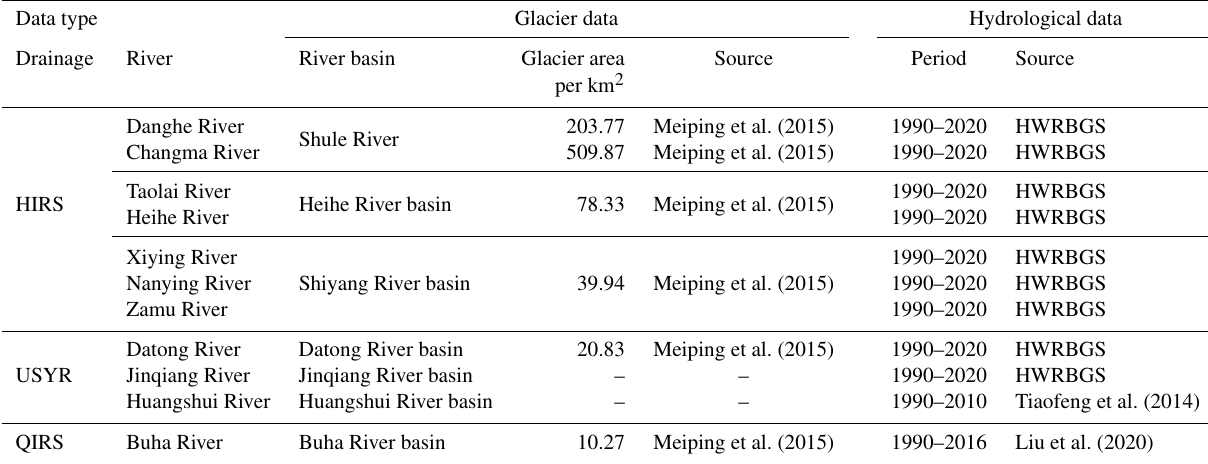
Table 1. Hydrological data of various basins in the Qilian